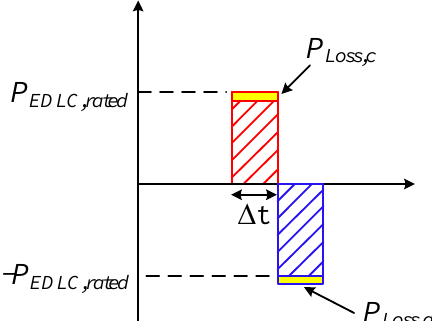
Figure 7. Charge/discharge energy of EDLC with rated power.